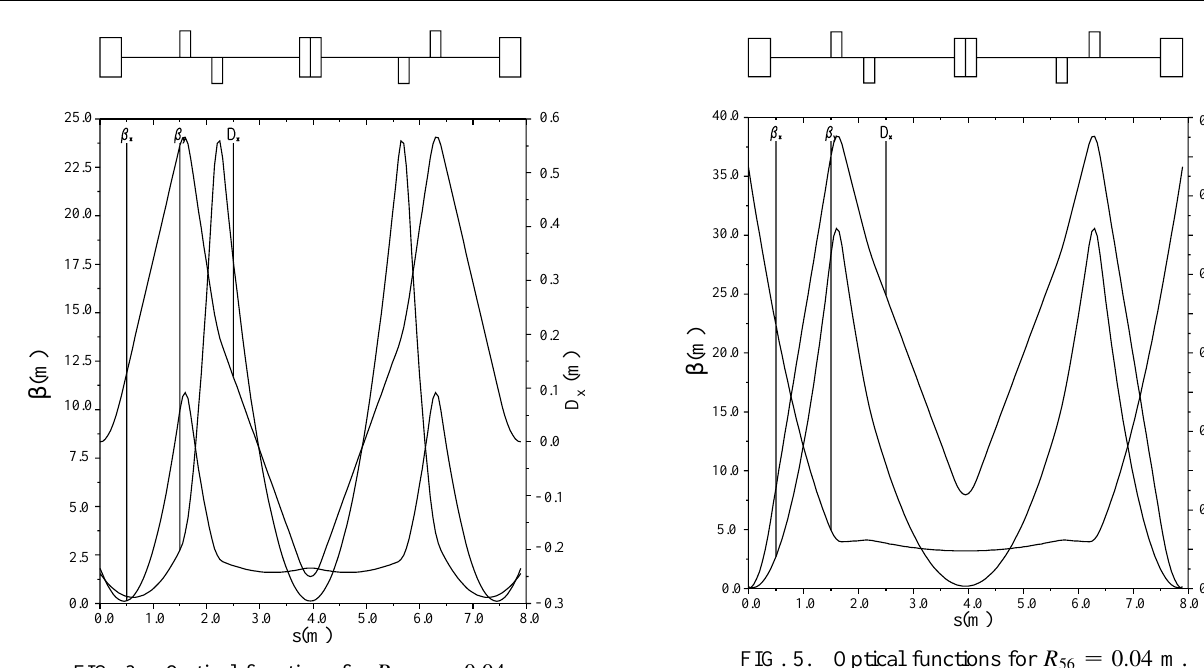
FIG. 3. Optical functions for R 56 (cid:1) 2 0.04 m.